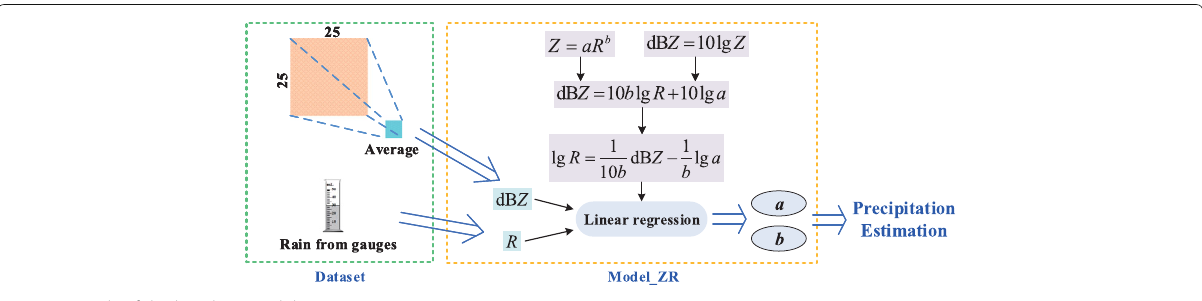
Fig. 3 Details of the baseline model